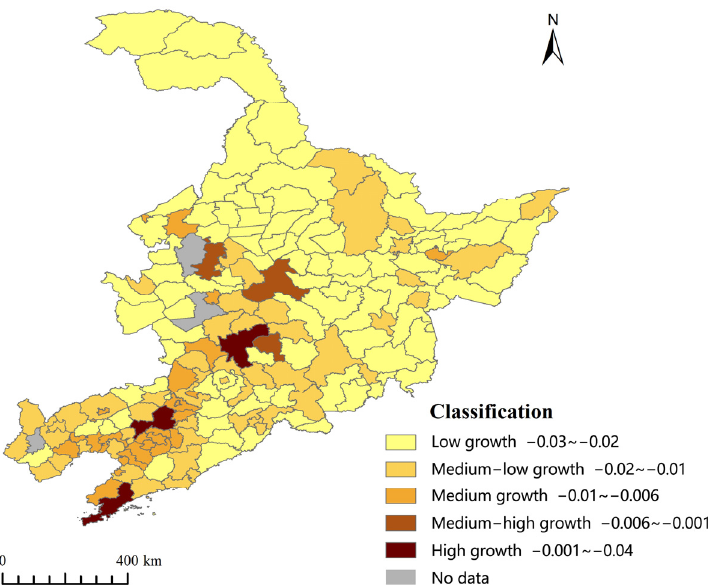
Figure 7. Classification of the rate of incremental carbon emissions in the counties of Northeast China 2012–2020.